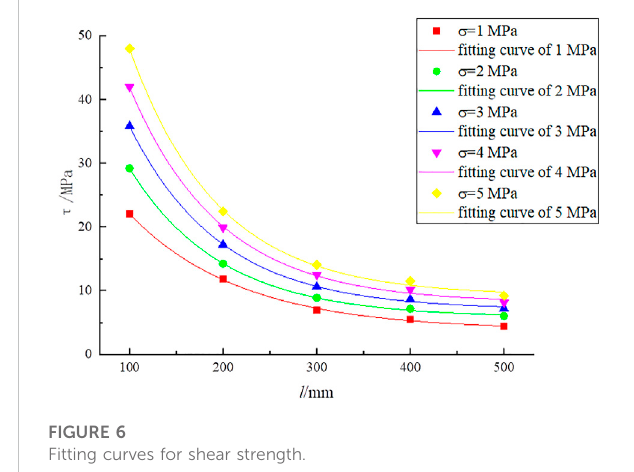
TABLE 7 Fitting model between SSSP and sizes.